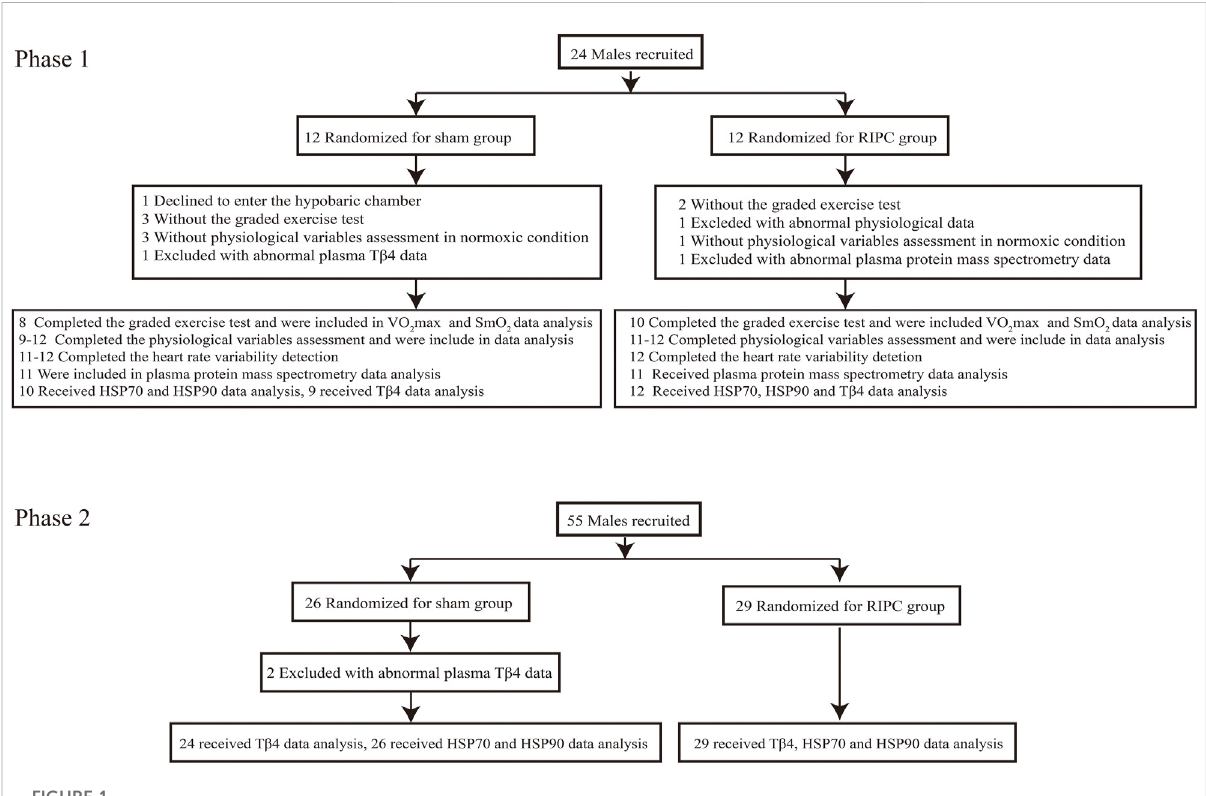
FIGURE 1 The recruitment fl ow